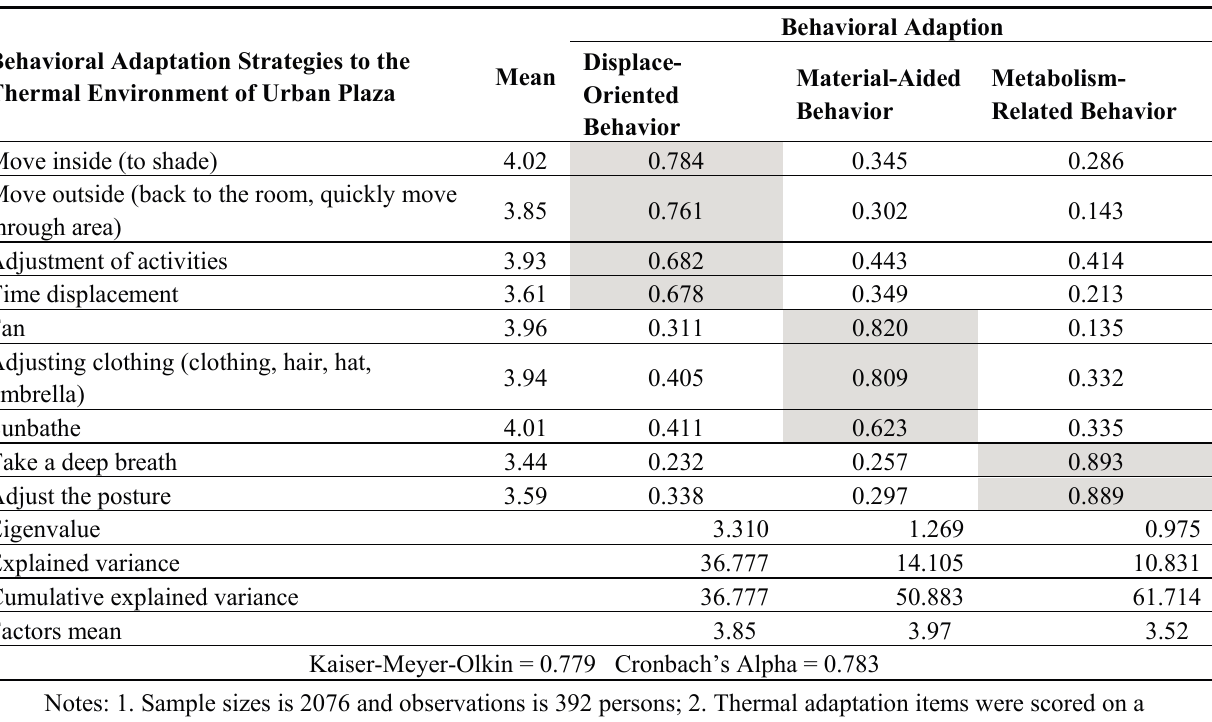
Table A1. Results of exploratory factor analysis of behavioral adaptation to the thermal environment of urban